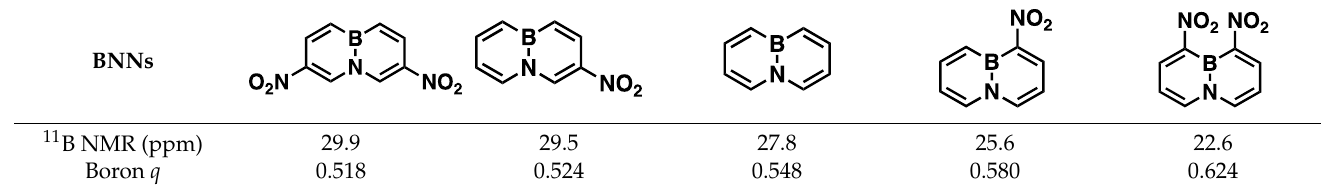
Table 1. 11 B NMR chemical shifts of nitrated BNN and corresponding boron π -electron density.